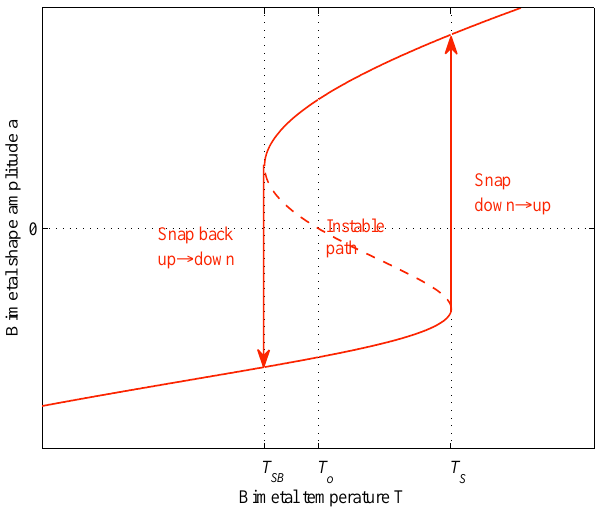
Figure 2. Hysteretic behaviour of bimetals.